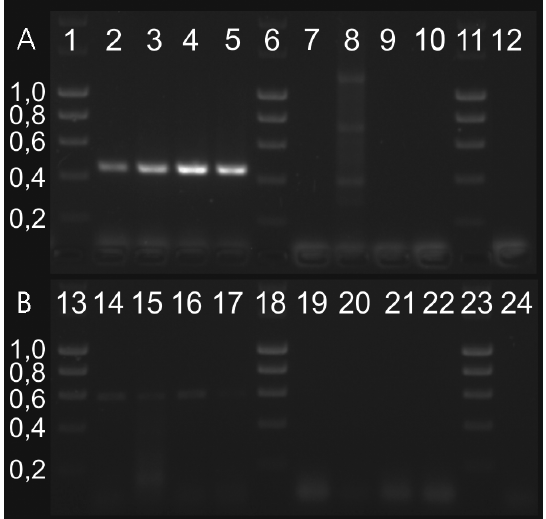
Fig. 2 – A , RT-PCR analyses detecting SmcGK1 transcripts of the expected size (452 bp) in pairing-experienced females (ef; lane 2); pairing-unexperiencedfemales(uf; 3); pairing-experiencedmales(em; 4); pairing-unexperienced males (um; 5). Controls: ef RT-negative (RT − ; 7); uf RT − (8); RT without template (9); em RT − (10); um